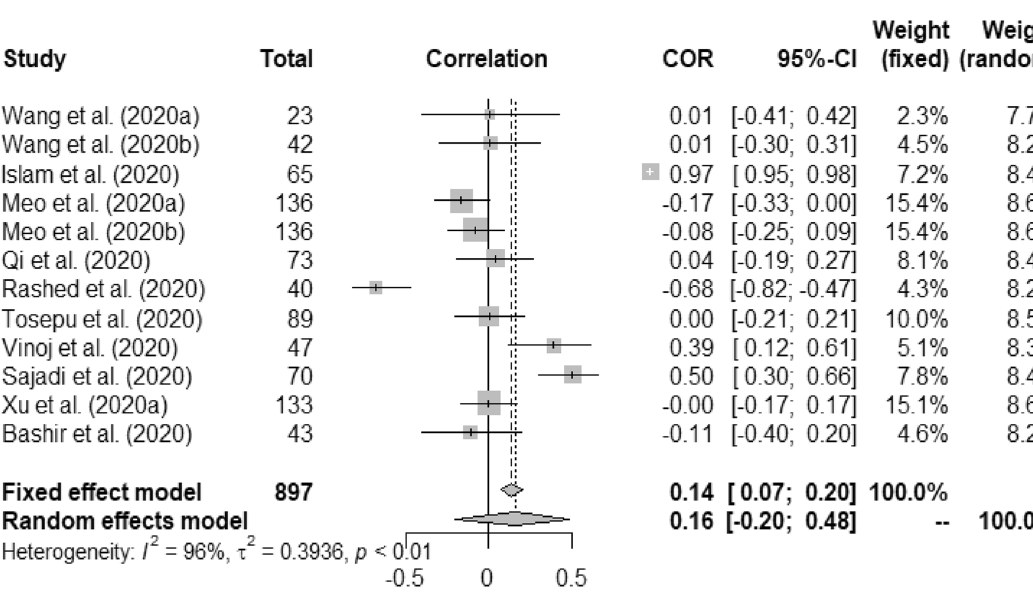
Figure 5. Forest plot of COVID-19 incidence with